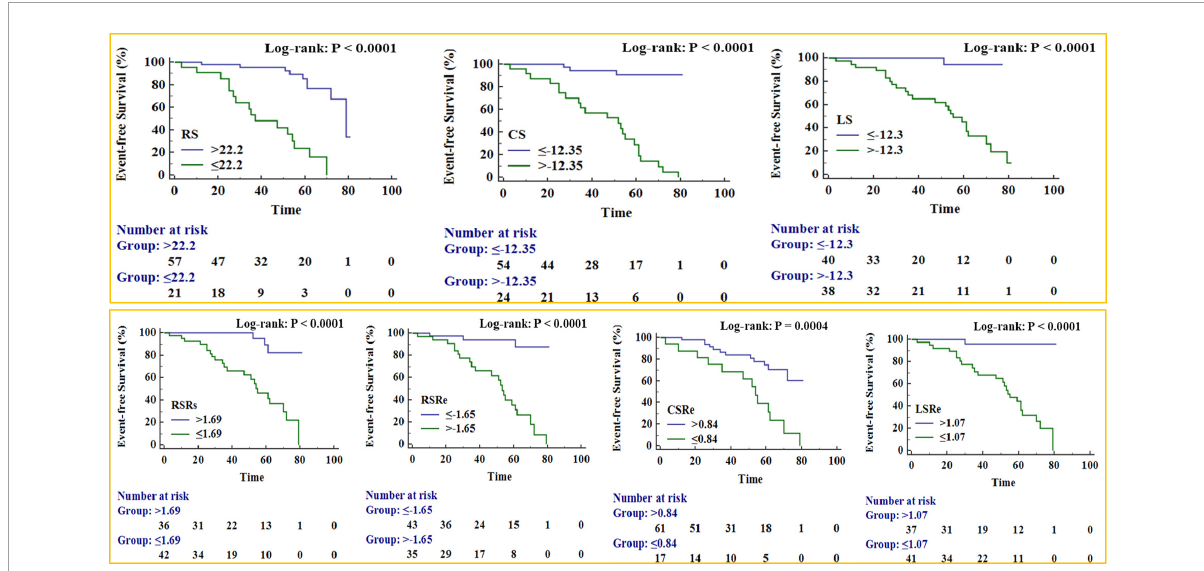
FIGURE5 Kaplan–Meier survival curves for patient subgroups stratified by peak radial strain (RS), peak circumferential strain (CS), peak longitudinal strain (LS), peak systole radial strain rate (RSRs), peak early diastole radial strain rate (RSRe), peak circumferential strain rate at end-diastole (CSRe), and peak early diastole longitudinal strain rate